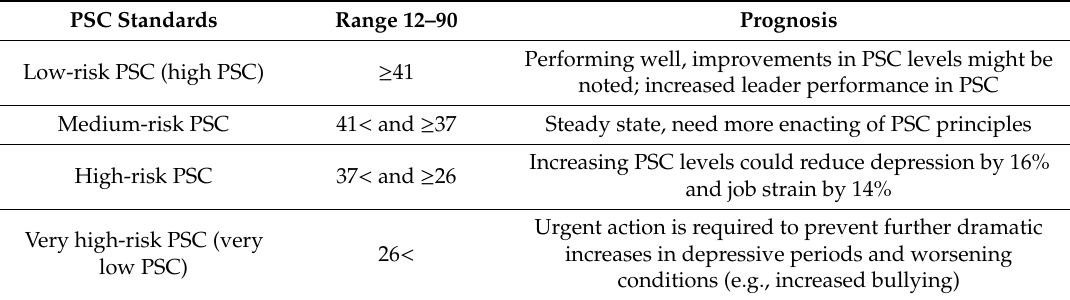
Table 2. The di ff erent risk categories of PSC-12 according to the PSC risk benchmarks (source: Centre for Workplace Excellence,